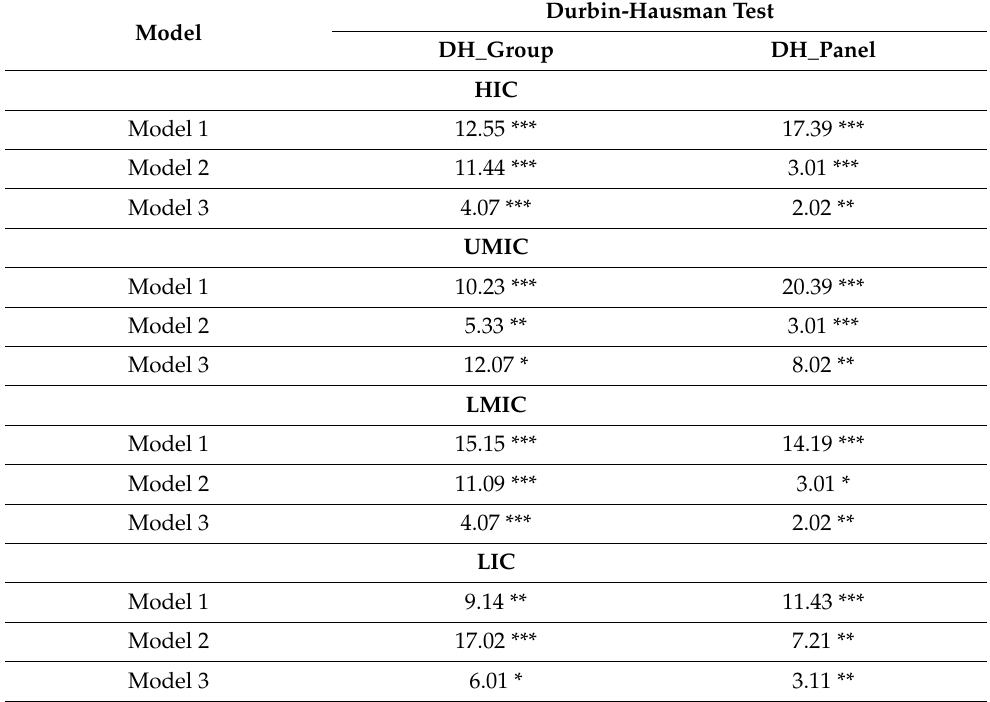
Table 5. Panel Cointegration